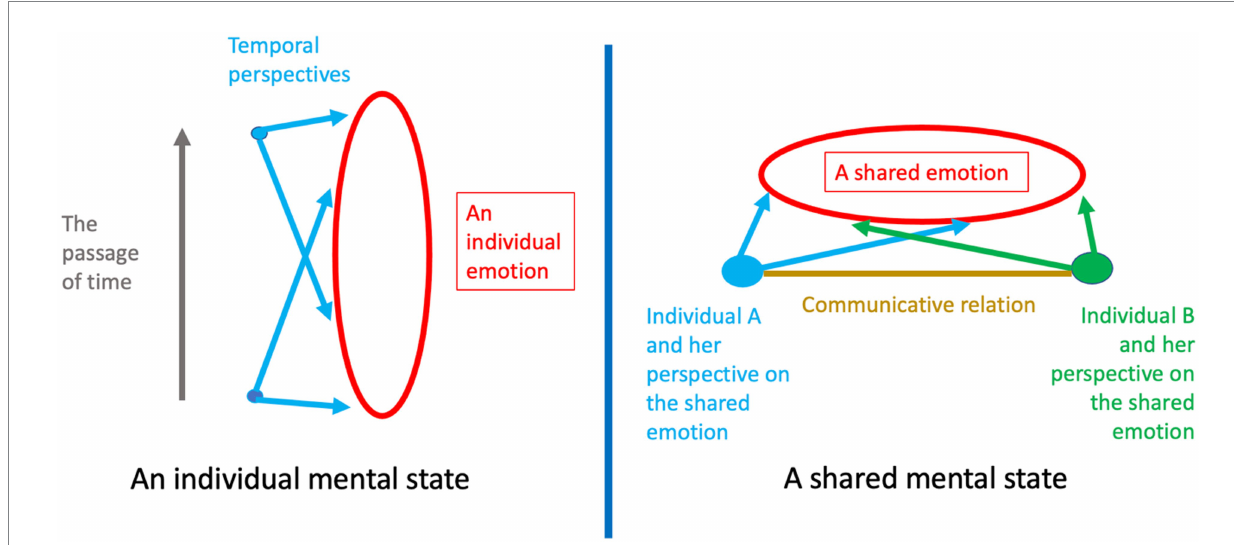
FIGURE 2 The structural analogy between individual and shared mental states. The elongated circle on the left represents an individual mental state. I take here an individual emotion as an example. The vertical axis along which the elongated figure unfolds represents the passage of time, signaling that the emotional episode is a process that lasts over time. At each point of time, the individual has a perspective on the whole of the emotion. Each of these perspectives is eo ipso a component, or factor, of the emotional process. For the sake of clarity, the graph shows only the perspectives that the individual has at an initial and a final point of the emotional episode—two couples of bifurcating arrows, the scope of which includes the entire emotional event, albeit from a specific angle. The most voluminous of the curved figures on the right represents a shared mental state. Again, I use a shared emotion as an example. The curved figure unfolds along the horizontal line, but it is implicitly assumed that a shared state is a process enduring over time just like an individual state. The minor circles represent two distinct individuals participating in the shared emotion (individual A and individual B). Each individual has a perspective on the emotional episode—a couple of arrows the scope of which includes the entire emotion, albeit, for each individual, from a specific angle. Each individual perspective is eo ipso a component, or factor, of the unitary process. The line connecting individual A and individual B represents the communicative relation subsisting between the two. An exchange of mutual looks or other reciprocal “communicative bids” can bring about the shared state (as explained in sections 4.2, 6). The structural analogy between individual and shared mental states is not restricted to emotions. For examples of perceptual, attentional states emphasizing their endurance over time in the individual case and their distribution across different individual perspectives in the shared case see Stein (2000), Carr (1986a), and Campbell (2002, 2005). For the structural analogy between individual and shared goals/intentions see Bratman (1993), Pacherie (2013), Sinigaglia and Butterfill (2022), and the examples of individual and joint actions provided in section